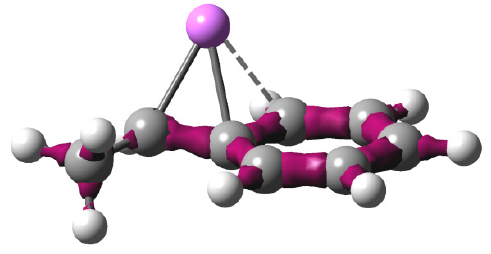
Figure 2-2. Electron density distribution of HStLi(2-a) (ea 0 − 3 = 0.25).